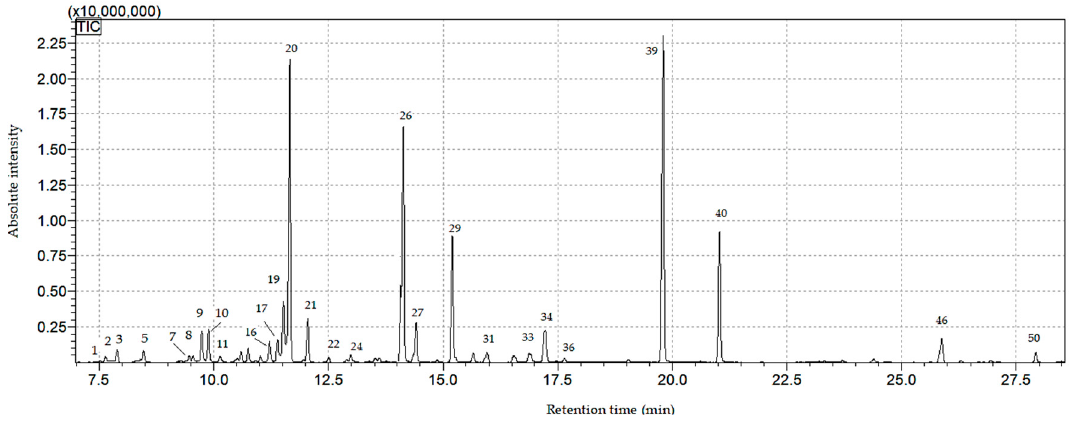
Figure 4. ITEX / GC-MS chromatogram of the volatile compounds from Lavandulae flos (SBE1000) Figure 4. ITEX/GC-MS chromatogram of the volatile compounds from Lavandulae flos (SBE1000) sample (for peak numbering see Table sample (for peak numbering see Table 4).